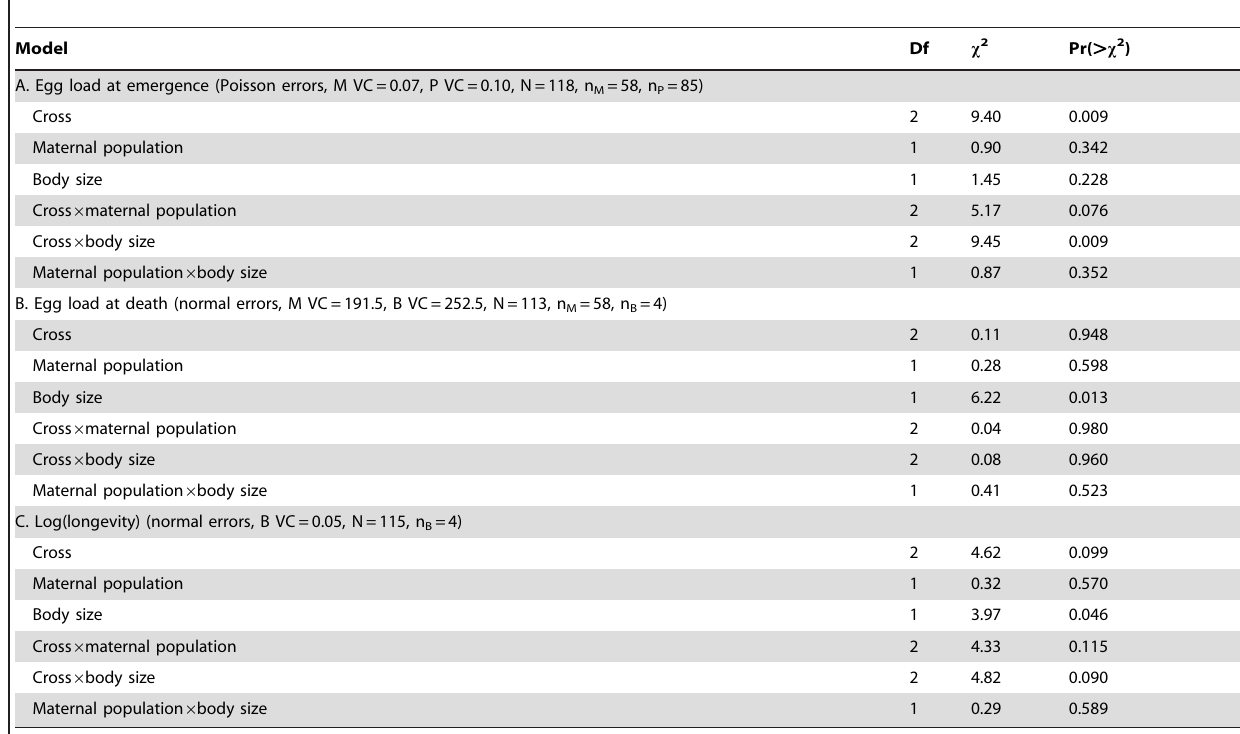
Table 1. Generalized linear mixed models for (A) egg load at emergence, (B) egg load at death and (C) longevity.